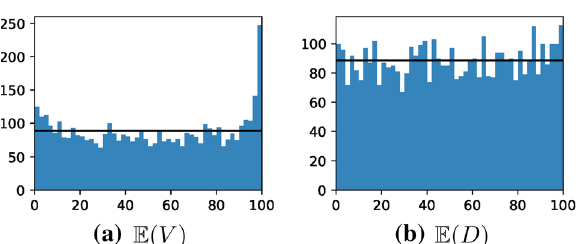
Fig. 5 Histogram of the theoretical quantity’s percentile rank as com- pared to the empirical samples across multiple statistical tests. If the theoretical value derived in Sect. 4 is exact, the histogram should show a uniform distribution with probability mass around the black line [29]